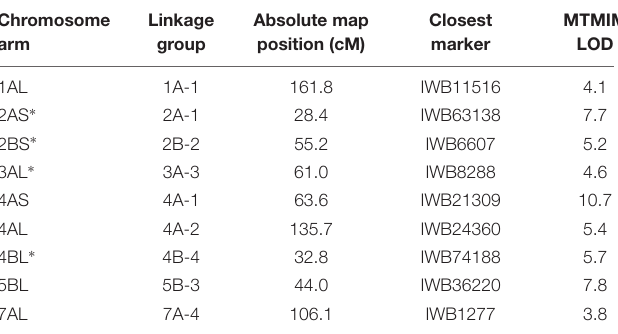
TABLE 6 | List of QTL detected for FHB incidence and severity by multiple trait multiple interval mapping (MTMIM) in the durum wheat RIL population derived from the cross between FHB-resistant 02-5B-318 line and FHB-susceptible cv. Saragolla; for each marker, one of the co-migrating loci at the same map position is reported.